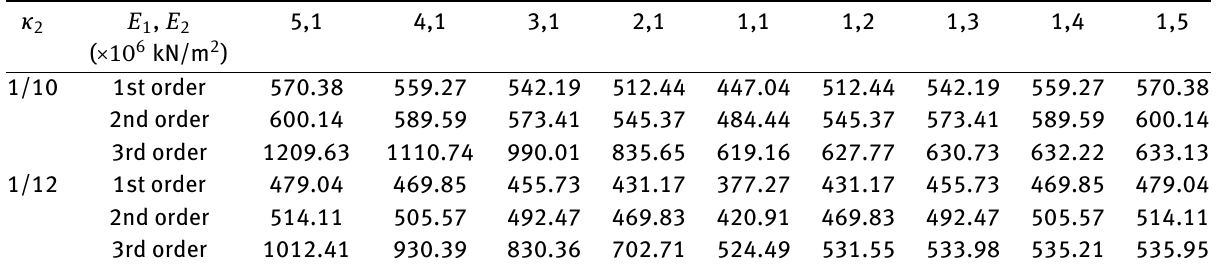
Table 4: The natural frequencies (rad/s) of analytical solutions under different elastic modulus ratios and rise span ratios